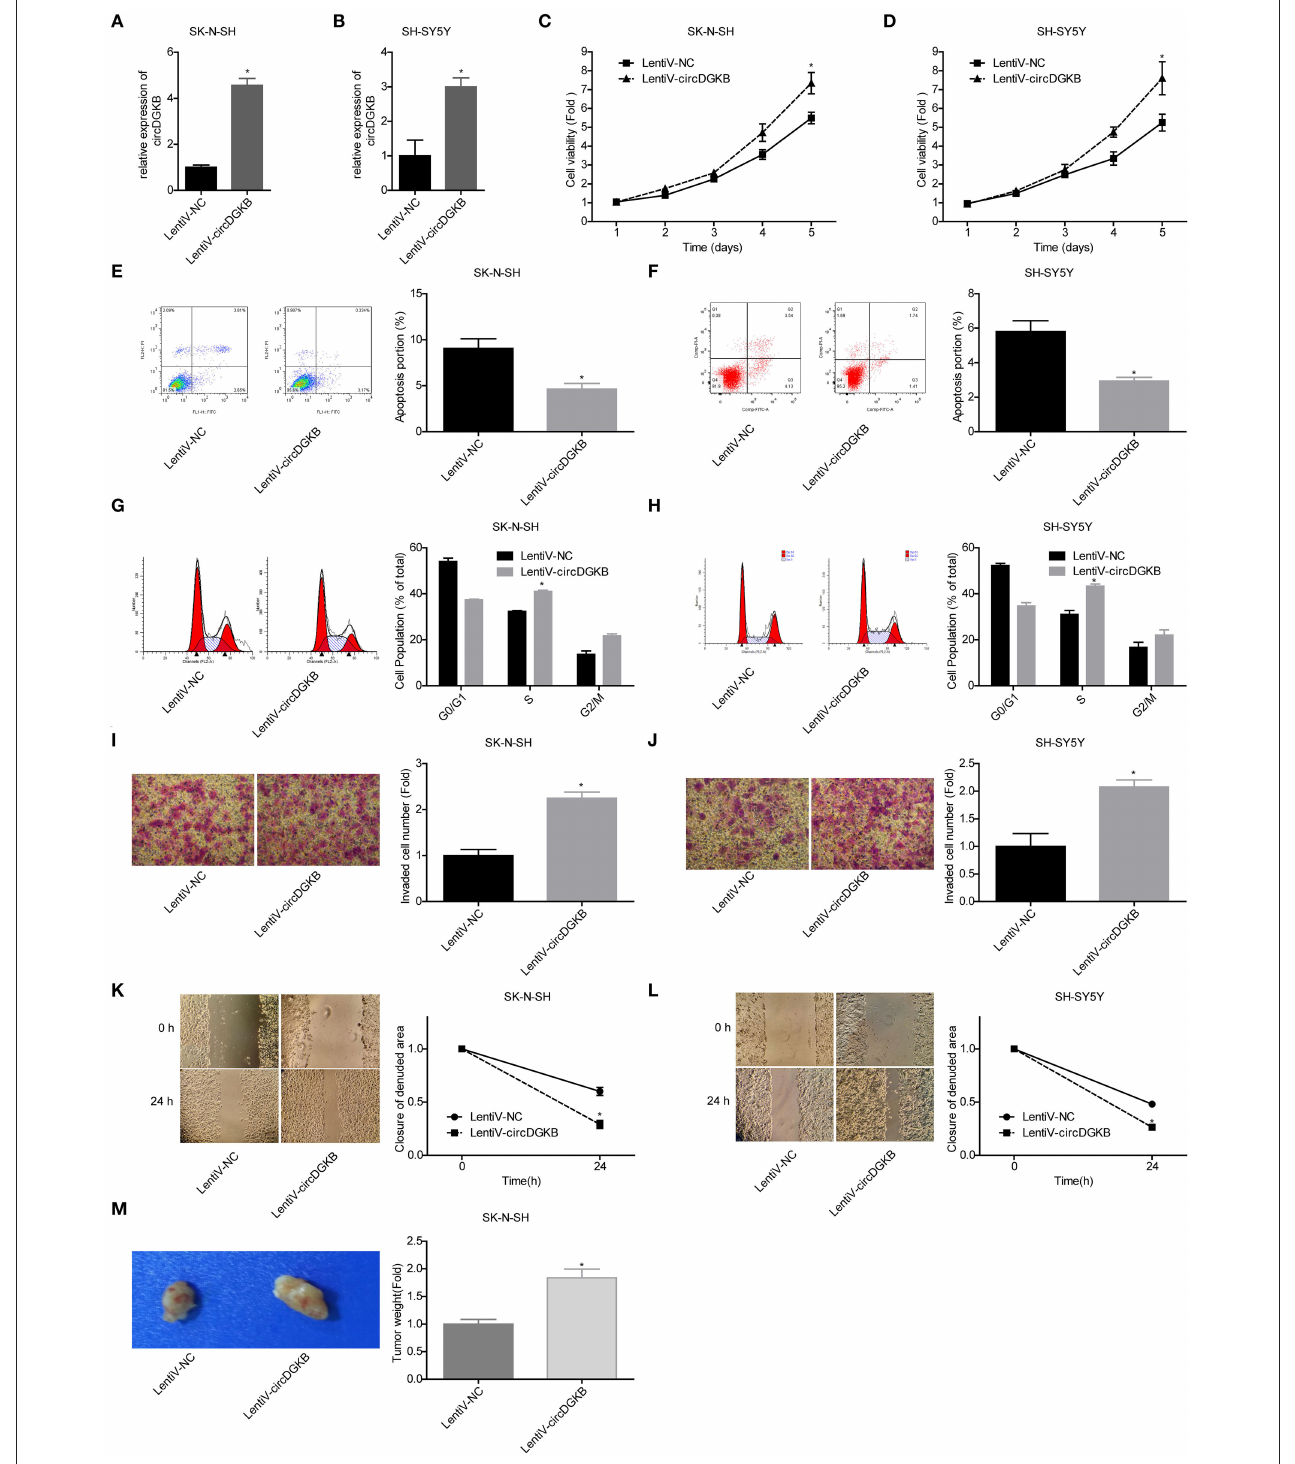
FIGURE 3 | Evaluation of the roles of circDGKB overexpression in NB cell proliferation, apoptosis and cell cycle, migration, invasion, and tumorigenesis. (A,B) QRT-PCR was taken to detect the infected efficiencies of Lentiv-circDGKB in SK-N-SH and SH-SY5Y cell lines. (C,D) CCK-8 assay was used to detect the proliferation of SK-N-SH and SH-SY5Y cells. (E,F) Flow cytometry was adopted to detected cell apoptosis. (G,H) Flow cytometry was used to determine the distribution of cell cycle. (I,J) Transwell experiment was performed to evaluate the invasion of SK-N-SH and SH-SY5Y cells. (K,L) Wound healing assay was performed to detect the migration of SK-N-SH and SH-SY5Y cells. (M) Nude mice tumorigenicity experiments was adopted to test the tumorigenesis of SK-N-SH cells in vivo (* P < 0.05 vs. Lentiv-NC group).